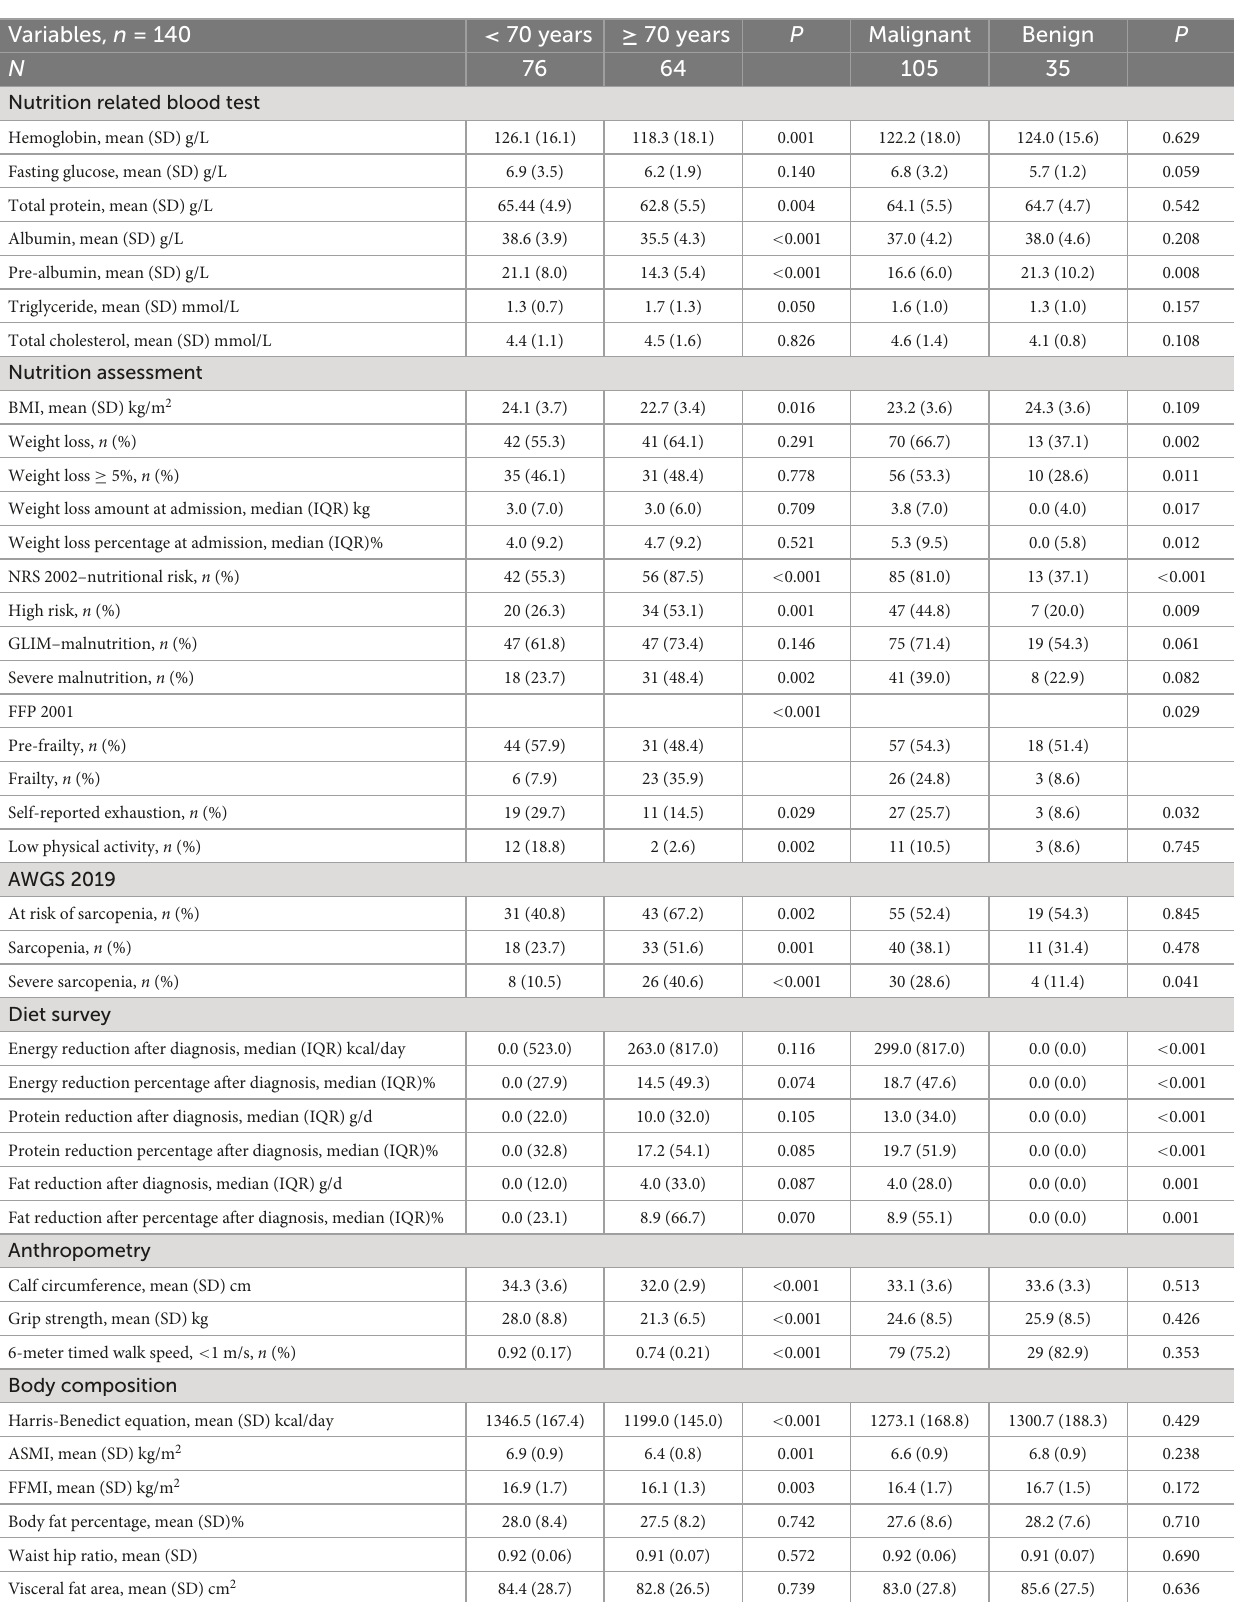
TABLE 4 Stratification